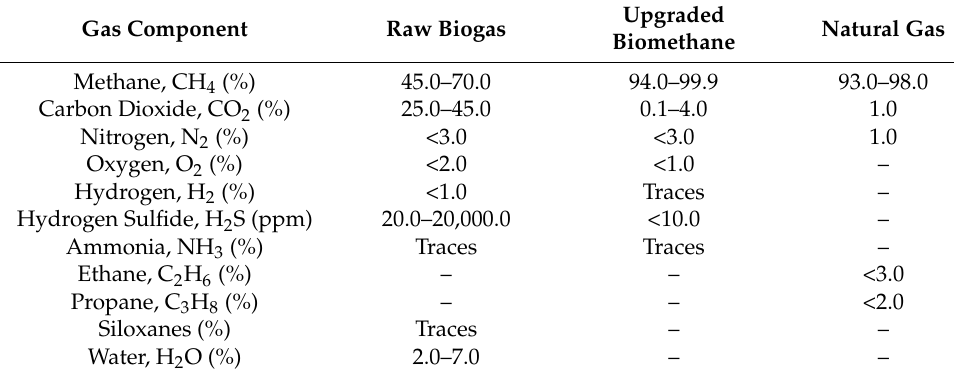
Table 4. Typical ranges and differences in the composition of raw biogas, biomethane, and natural gas as reference. Data processed from Refs. [90,106–108].